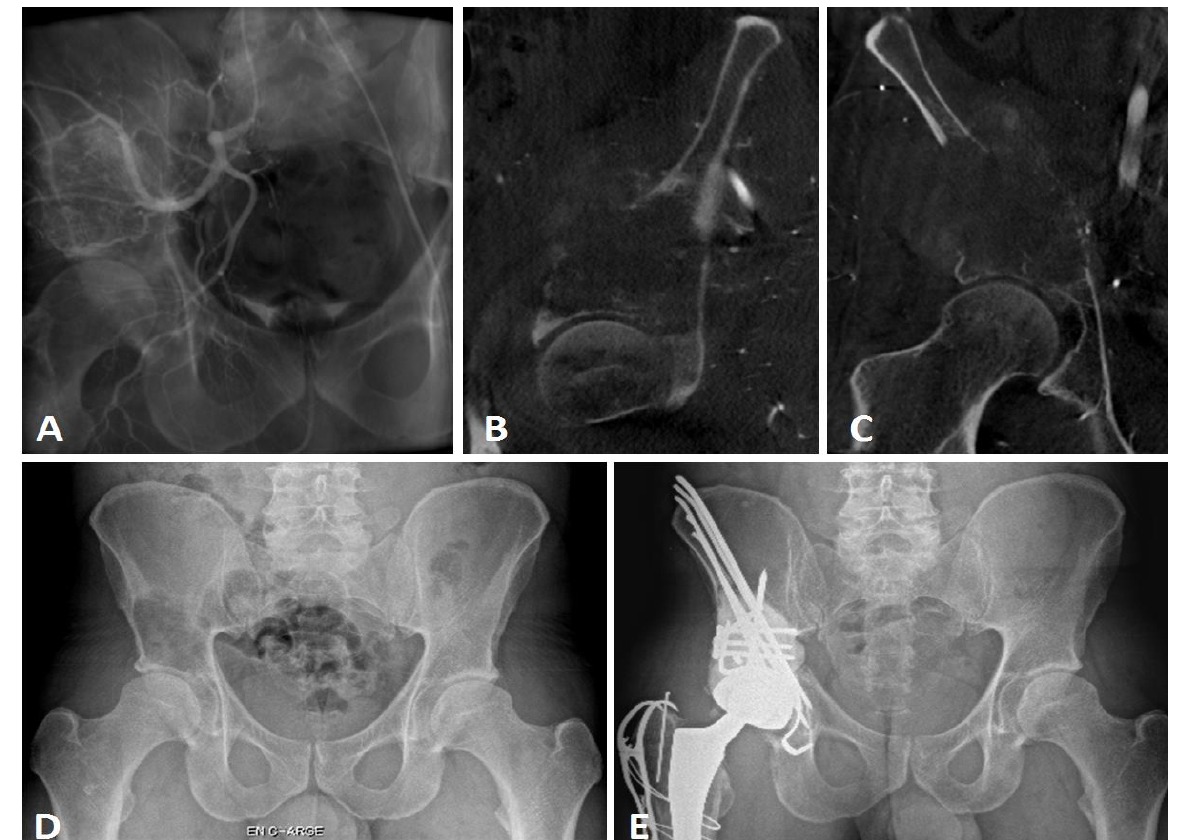
Figure 2. Imaging views of a GIST metastatic iliac lesion Harrington class III. Scout view ( A ) during the preoperative embolization, sagittal view ( B ) of the periacetabular lesion, frontal view ( C ). X-ray AP view of the pelvis before surgery ( D ), and postoperative X-rays at 18-month follow-up ( E ).